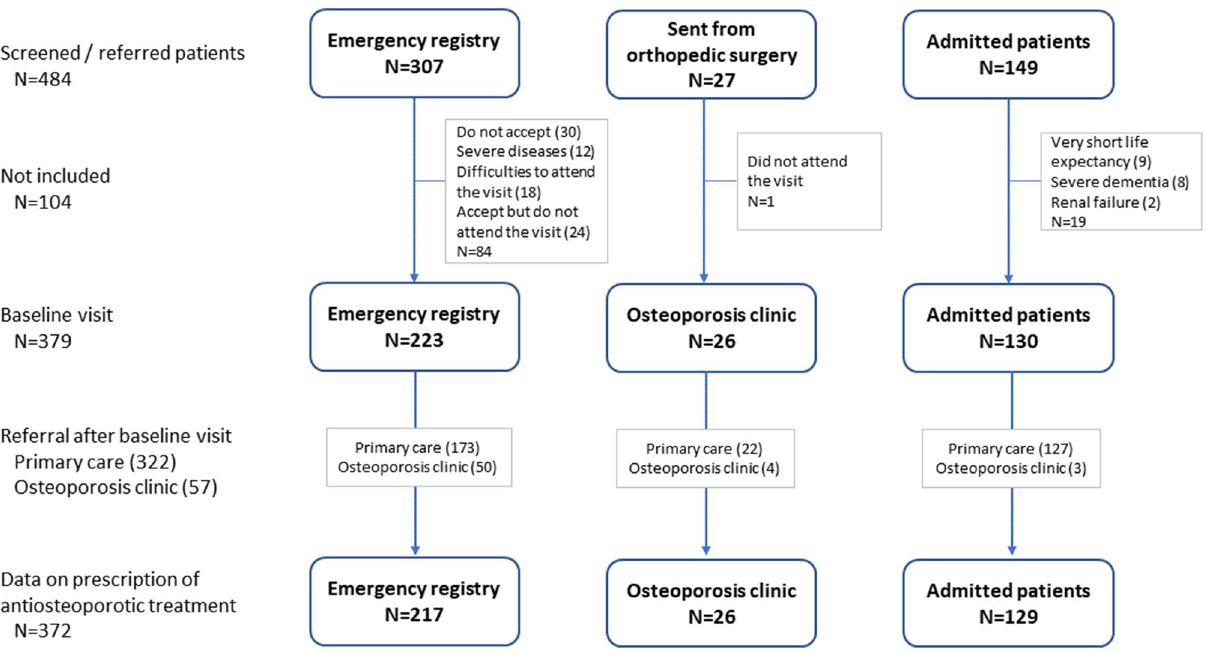
Figure 1. Flow diagram of patients. Edited with Microsoft 365 A3 for